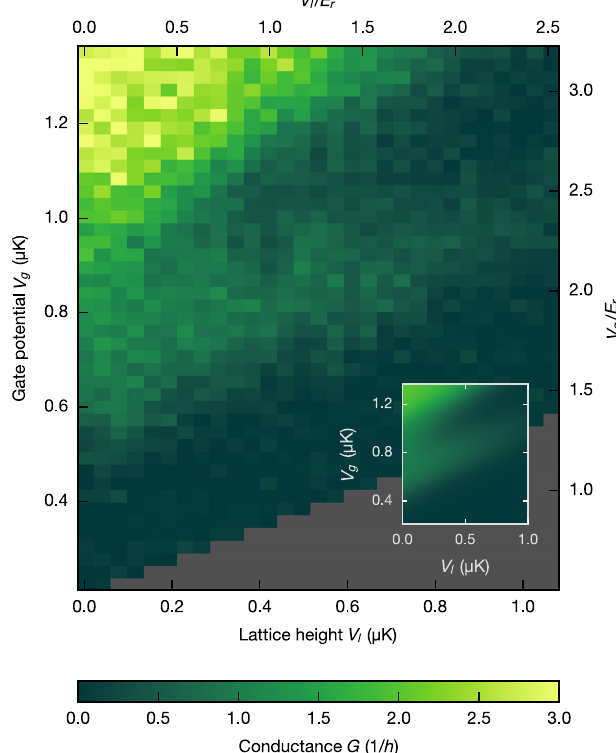
V . The experimental data are in very good agreement with l finite-temperature, noninteracting theory shown as inset in Fig. 3 except in the two-mode regime at large V conductance is larger than two conductance quanta 2 =h .